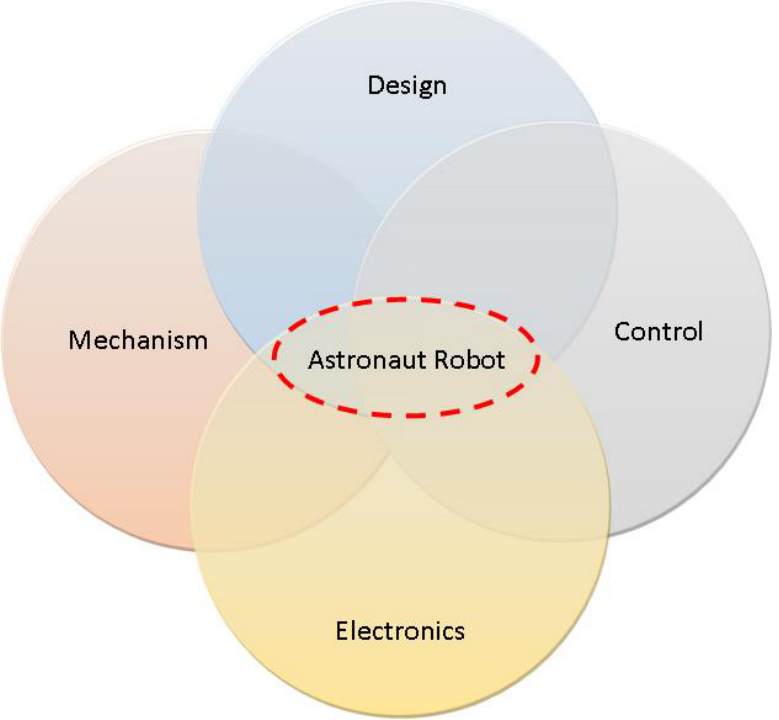
Figure 1. A framework for designing outer space astronaut robot design.